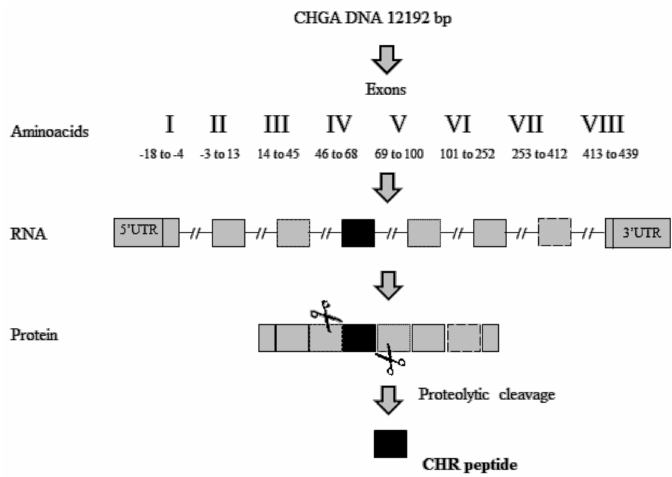
Figure 3. Schematic representations of Chromofungin (CHR) peptide derived from proteolytic cleavage of Human chromogranin-A (CHGA) protein, UTR: UnTranslated Region.